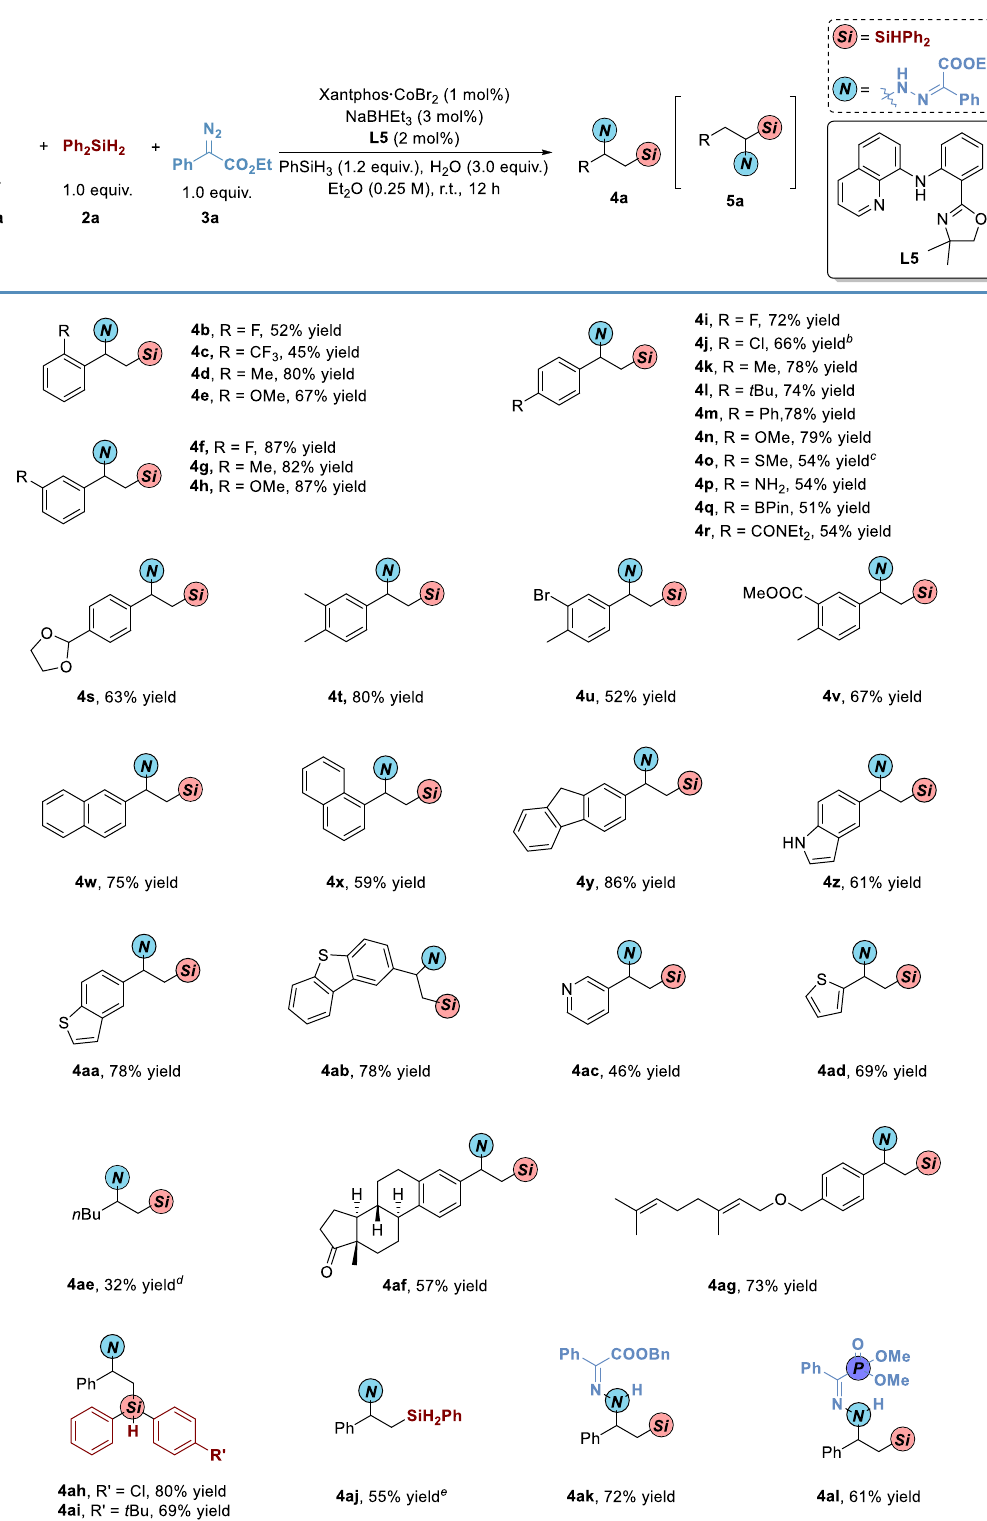
Fig. 4 Substrate Scope of Sequential Hydrosilylation/Hydrohydrazidation of Terminal Alkynes via Ligand Relay Catalysis. a Reaction conditions: 1 (0.3 mmol), 2 (1.0 equiv.), 3 (1.0 equiv.), Xantphos (cid:129) CoBr 2 (1 mol %), NaBHEt 3 (3 mol %), L5 (2 mol %), PhSiH 3 (1.2 equiv.), and H 2 O (3.0 equiv.) in Et 2 O (1.2 mL) under nitrogen at room temperature for 12 h, isolated yield of 4 with complete regioselectivity without additional indications. b Stirred in THF, without H 2 O. c Stirred for 24 h. d L11 (see Supplementary Information) was instead of L5 , PhMeSiH 2 was instead of PhSiH 3 , without H 2 O and stirred for 24 h (7/1 rr ). e DPEphos (cid:129) CoBr 2 was instead of Xantphos (cid:129) CoBr 2 , PhSiH 3 was instead of Ph 2 SiH 2 .